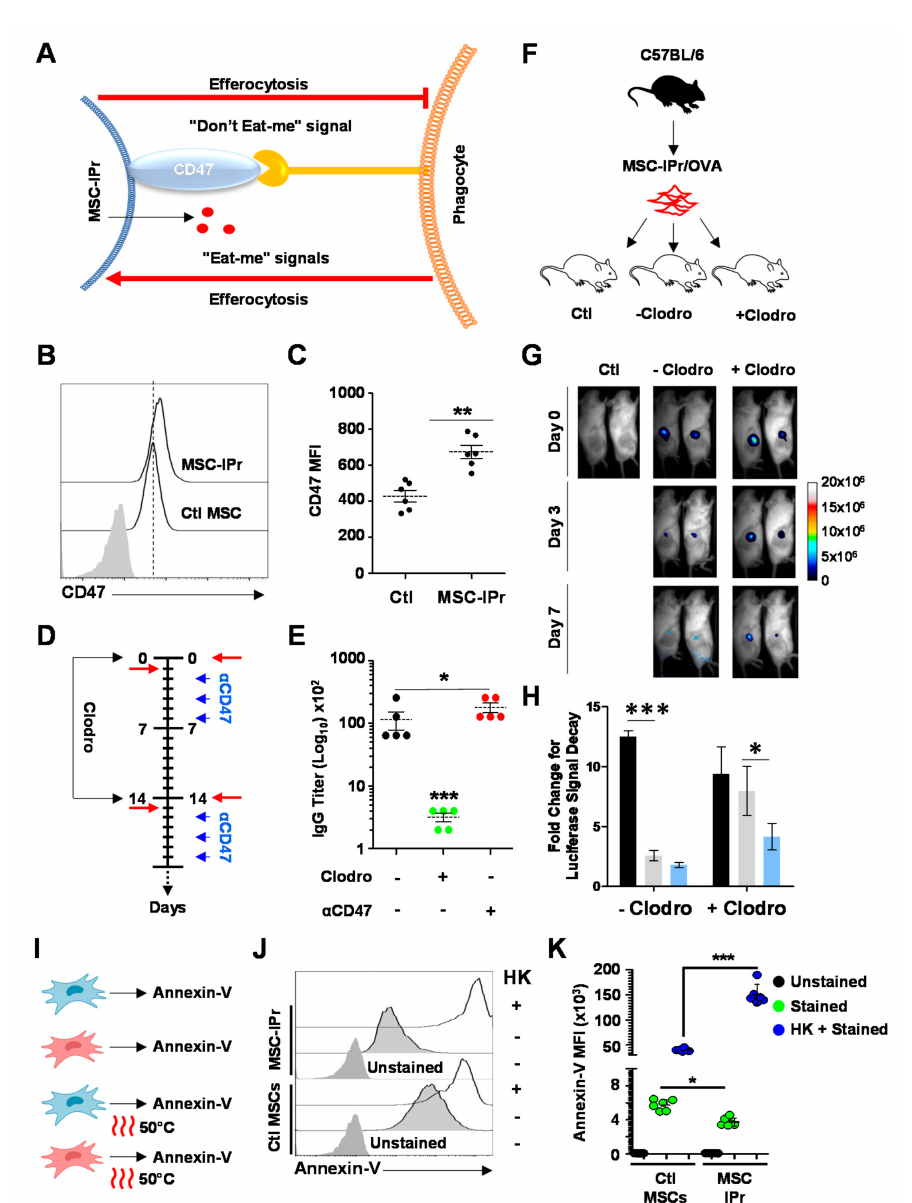
Figure 6. Efferocytosis is required to humoral responses induced by allogeneic MSC-IPr. ( A ) Schematic diagram representing the interplay between MSC-IPr and phagocytes. ( B , C ) Rep- resentative flow cytometry ( B ) analysis of CD47 expression on the surface of MSC-IPr versus Ctl MSCs and its cognate MFI ( C ). ( D ) Schematic diagram reflecting the immunization schedule OVA- pulsed MSC-IPr in the presence or absence of anti-CD47 or clodronate. Red arrows represent SC injection of MSC-IPr. ( E ) IgG titer analysis by ELISA in sera isolated from mice vaccinated using allogeneic MSC-IPr as a combination with anti-CD47 or clodronate or alone. ( F ) Schematic diagram showing the design of the live in vivo imaging study. ( G ) Representative live in vivo imaging of mice implanted with luciferase-expressing MSC-IPr administered to mice with previous liposome or clodronate-liposome injection. ( H ) Quantification of luciferase luminescence signal change at days 0, 3 and 7 post-injection. ( I ) Schematic diagram showing the Annexin-V staining design for live or HK Ctl MSCs (blue cells) or MSC-IPr (red cells). ( J ) Representative flow cytometry analysis of Annexin-V on the surface of live or HK-MSCs. ( K ) Annexin-V MFI of the experiment shown in panels I–J. For panel C, n = 6/group with ** p < 0.01. For panel E–H, n = 5 with * p < 0.05 and *** p < 0.01. For panel K, n = 6/group with * p < 0.05 and *** p < 0.001. Bars represent